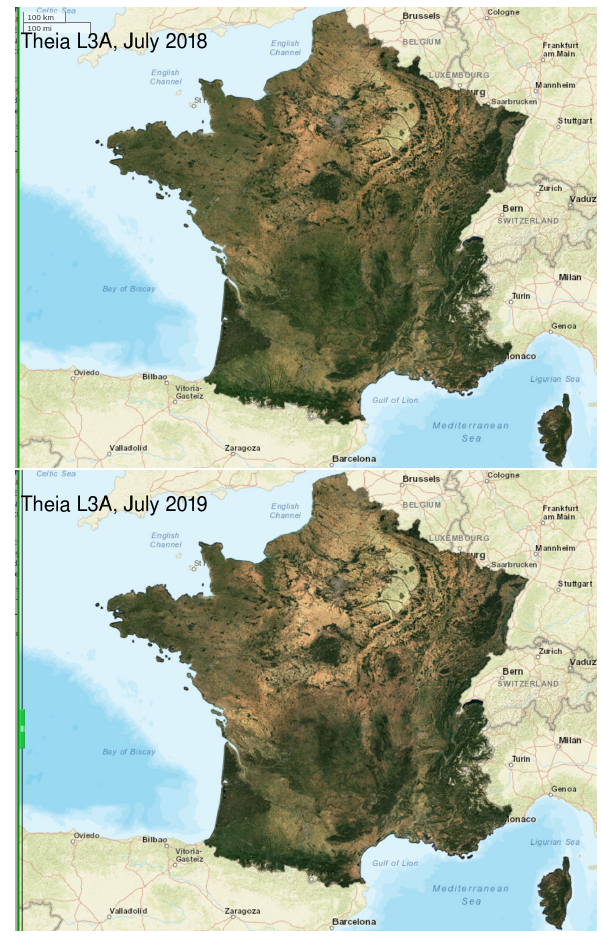
Figure 7. True colour images of monthly syntheses of Sentinel-2 surface reflectance in France in July 2018 (top) and 2019 (bottom), generated using MAJA and WASP ucts were available. This simple processor used linear inter- polation within closest cloud free dates to generate cloud